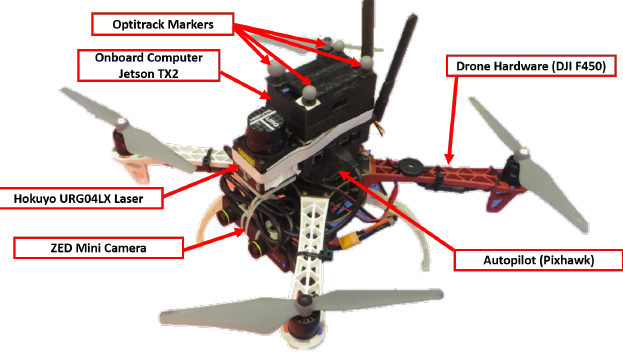
Figure 12. The quadrotor hardware components.